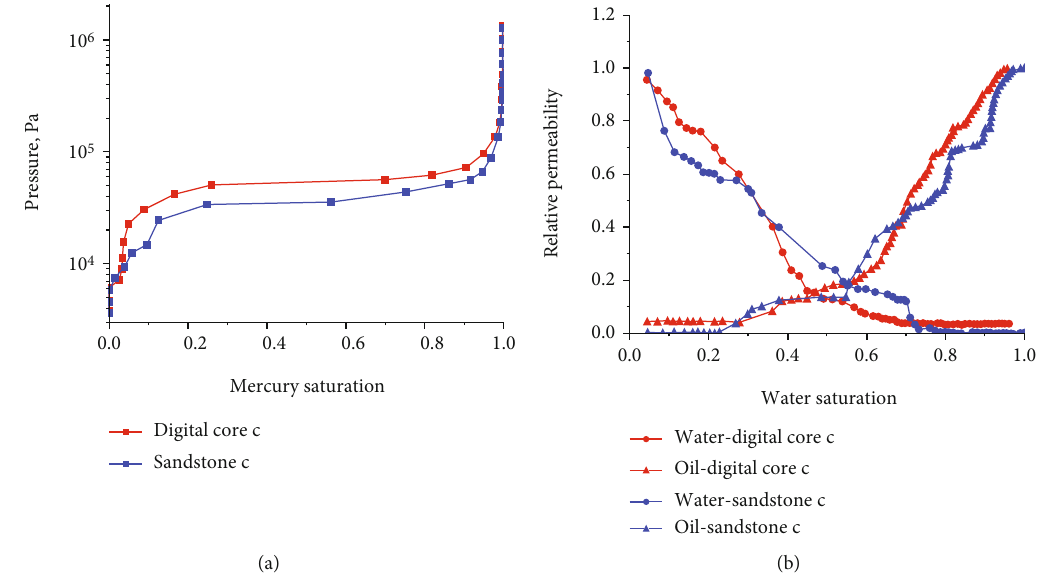
Figure 22: (a) Mercury injection and (b) oil-water two-phase fl ow simulation of digital core c and sandstone c.